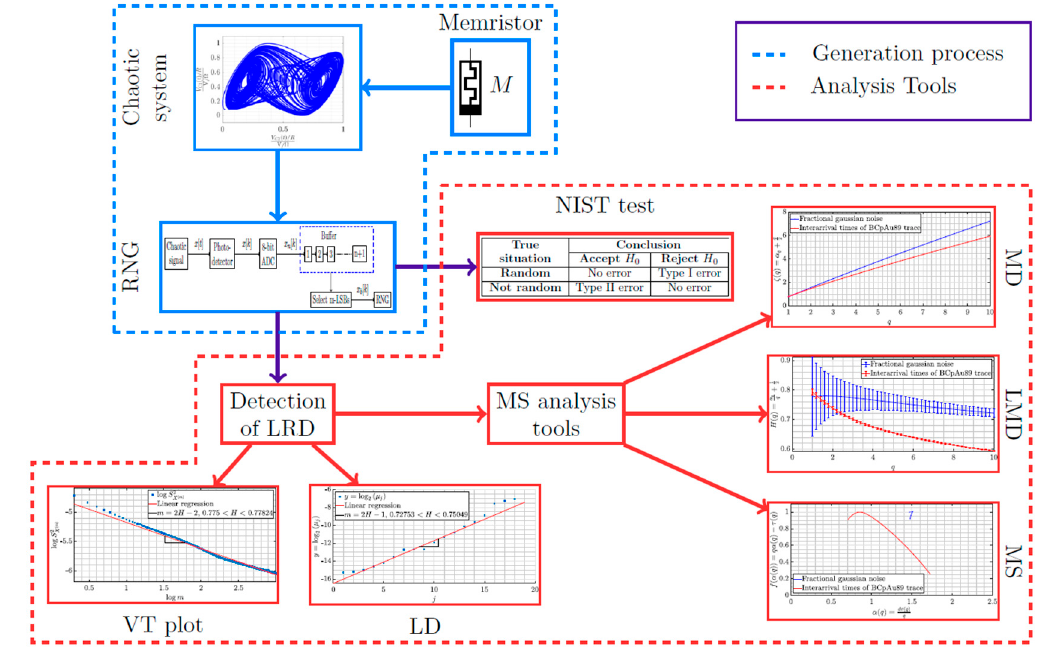
Figure 1. Schematic diagram of the methodology implemented in the research.